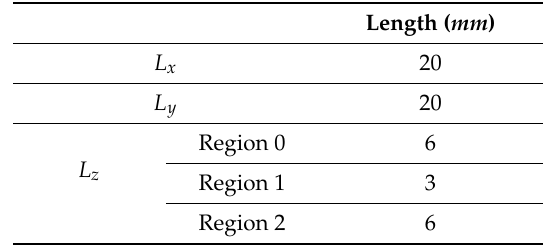
Table 2. Geometry setup for numerical investigation and validation.